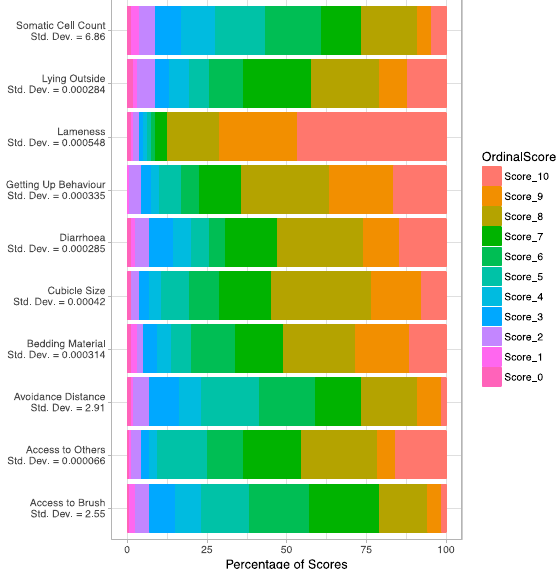
Figure 3. Cumulative horizontal bar charts showing the proportion of scores returned in the raw data ( x axis) for each measure ( y axis). Estimates of the standard deviation associated with the random effect of respondent obtained from the cumulative link random effects model are shown underneath the measure name on the x -axis labels.